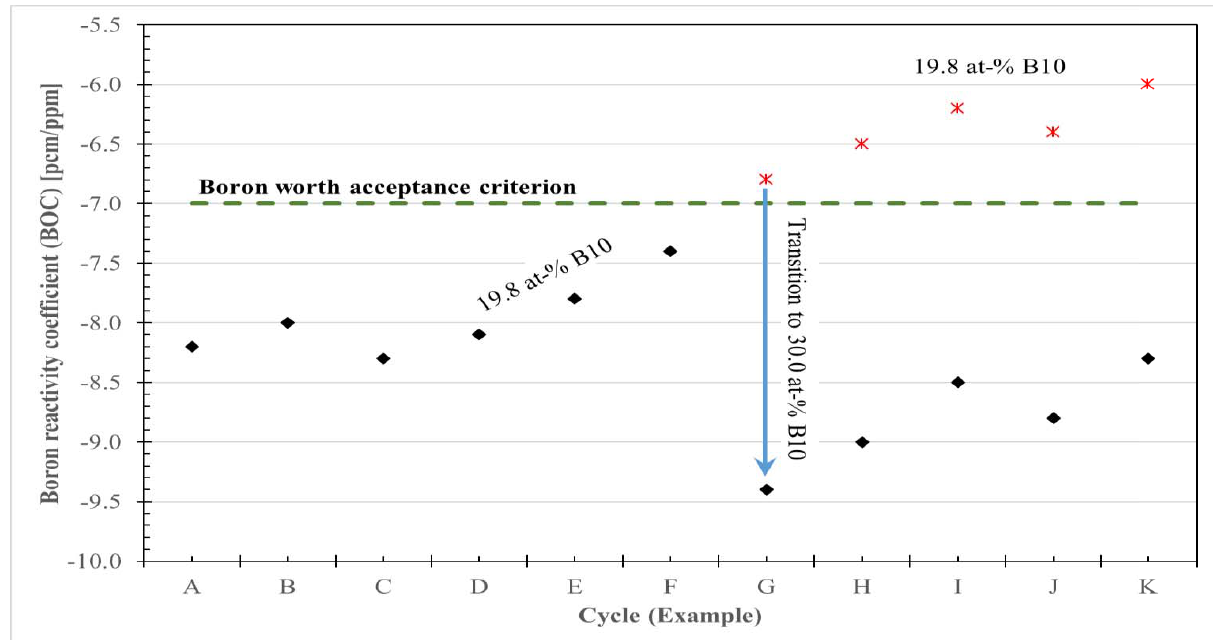
Figure 2. Boron Reactivity Coefficient at Beginning of Cycle with Natural (19.8 at-% B10) and Enriched